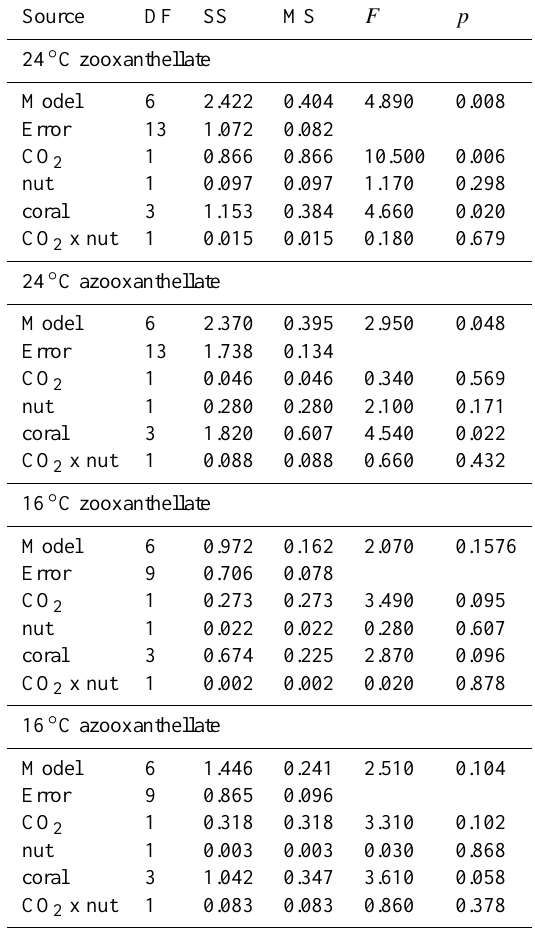
Table 2. ANOVA results for the effects of CO 2 , nutrients (nut), and interaction there of on the change in relative calcification rates, using the source coral colony (coral) as a blocking